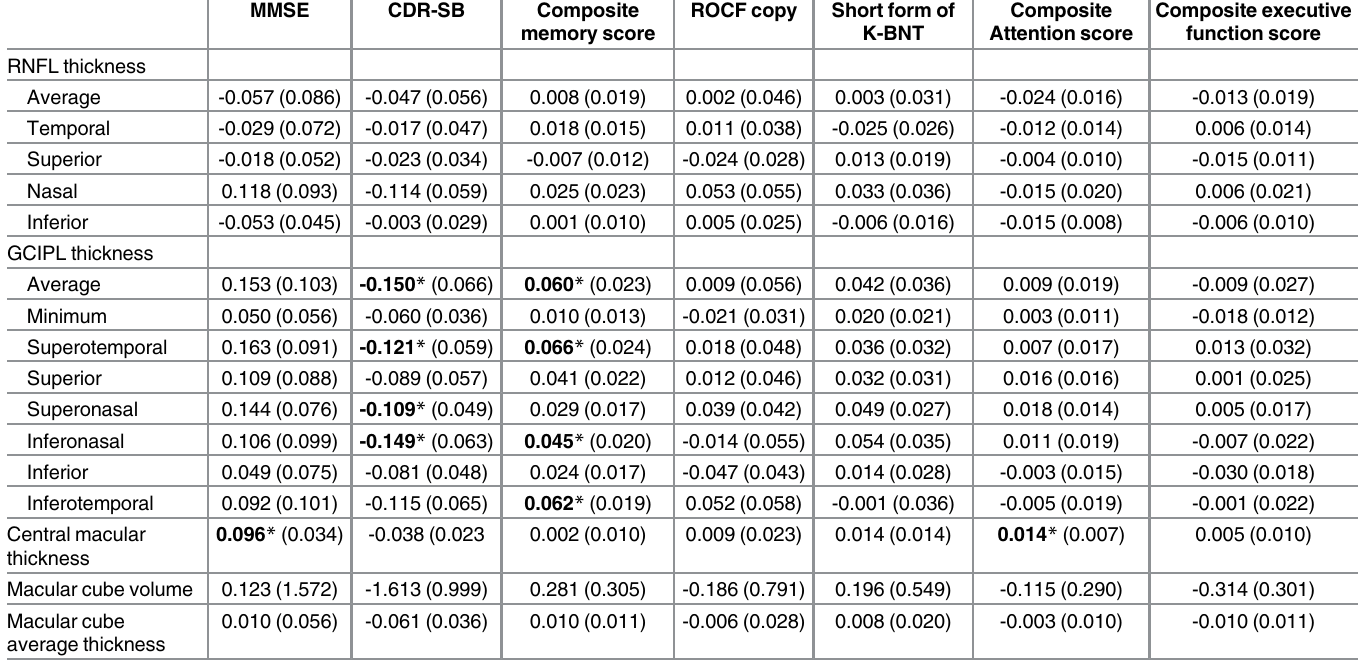
Table 3. Relationship of the baseline cognitive function scores with the thicknesses of retinal nerve fiber layer (RNFL) and ganglion cell inner plex- iform layer (GCIPL) in the patients with Alzheimer ’ s disease or mild cognitive